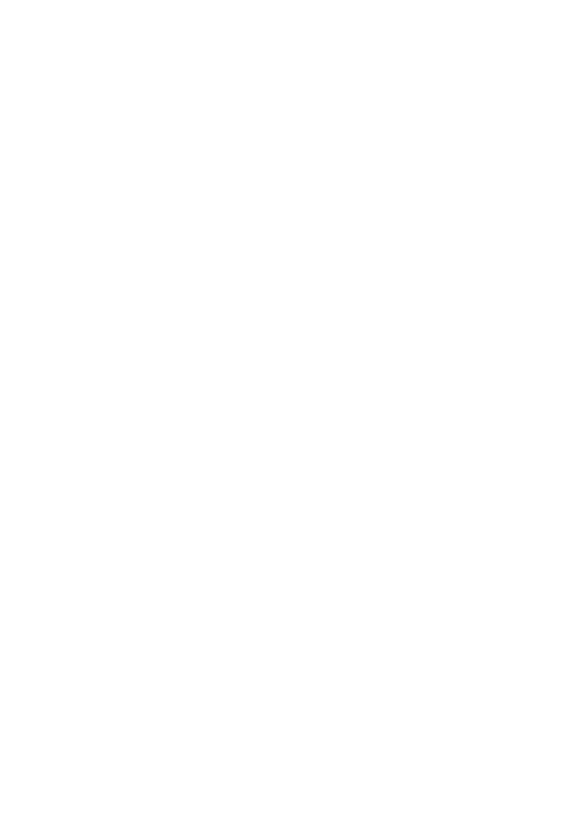
Fig. 14 Comparison of strain versus cross-section height: a for control beam; b for strengthened